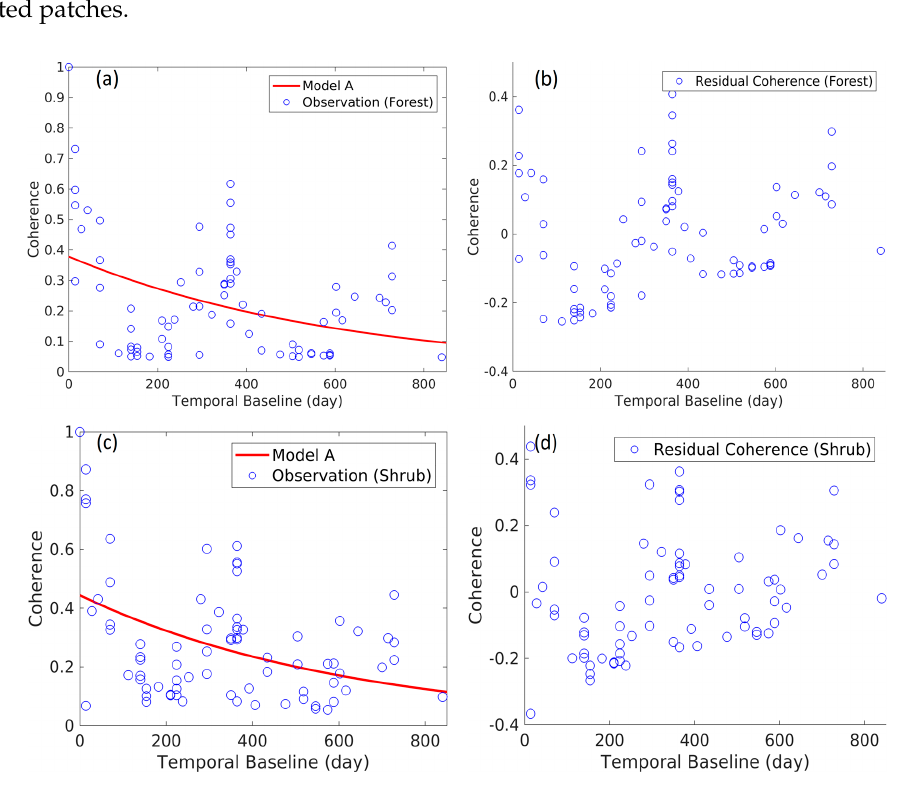
Figure 2. Scatter plots of observations and model A for forested ( a ) and shrub ( c ) land cover types. Scatter plots of residual coherences (observation—model A) for forested ( b ) and shrub ( d ) land cover types.